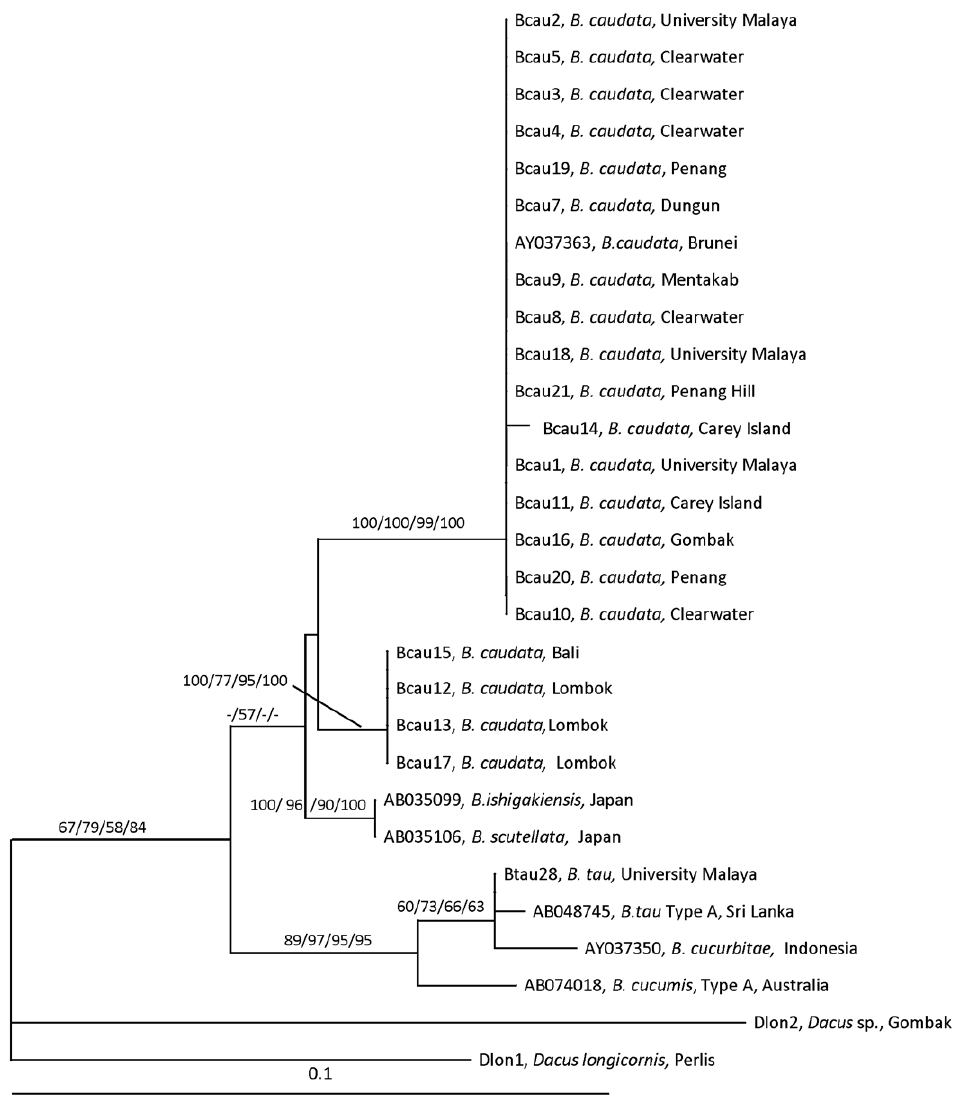
Figure 5. The 50% majority-rule consensus tree resulting from maximum likelihood analysis of partial 16S rDNA sequences (substitution rate parameters: TC= 0.6192997; TA = 0.02629145; TG = 0.02629145; CA = 0.07552851; CG = = 0.07552851; AG=0.1770604). -Ln likelihood was 981.8218. The bootstrap values (ML/Bayesian Inference/MP/NJ) are shown at the branches. Bar indicates substitutions per